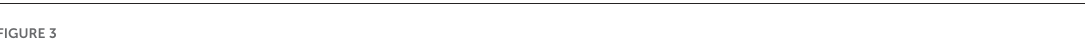
FIGURE3 type, lifeform, or mycorrhizal association, and different letters indicate significant differences at α = 0.05. *** p < 0.001. AM, arbuscular mycorrhiza; ECM, ectomycorrhiza; Both, plants associated with both AM and ECM fungi.